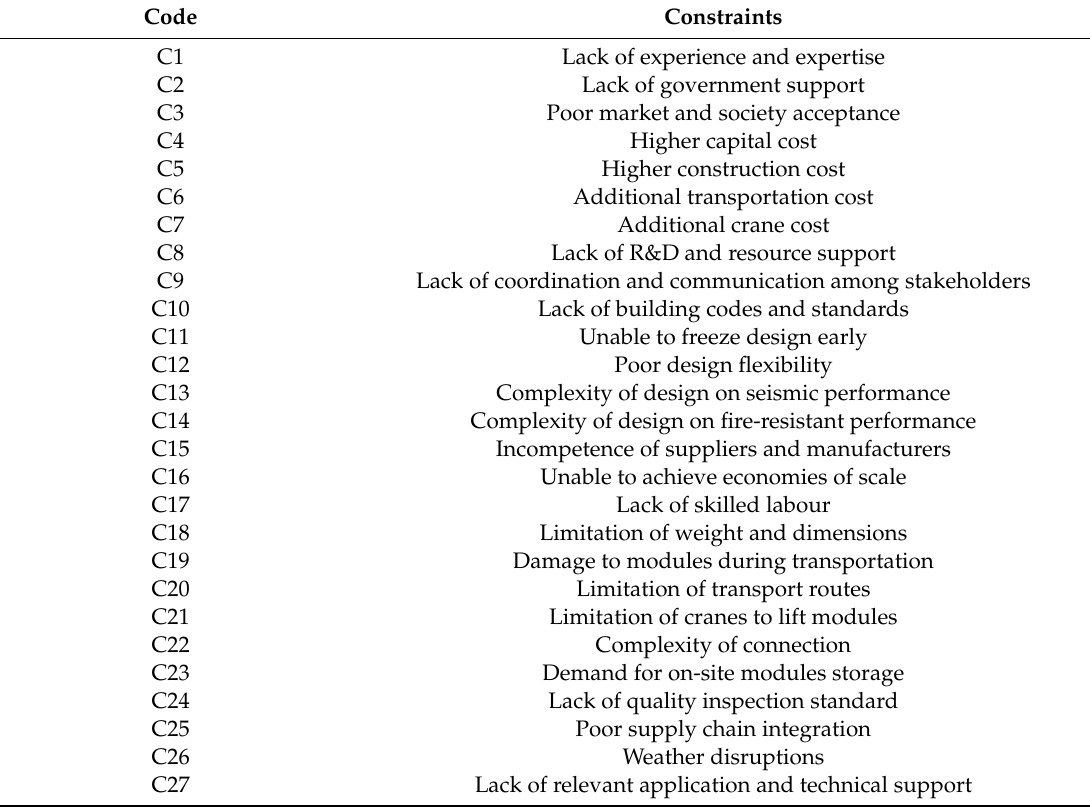
Table 3. The final list of constraints hindering the development of modular